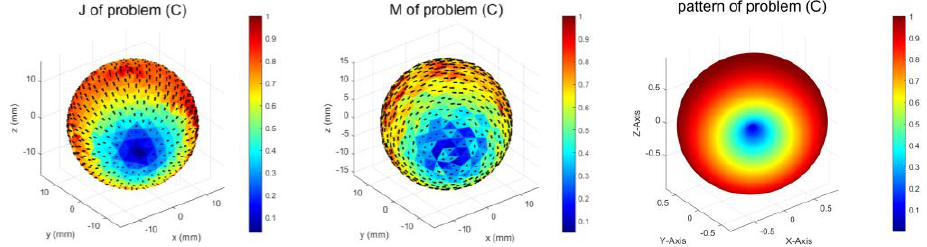
Figure 16. Characteristic current distributions and normalized pattern of mode 3 resonating near 4.3 GHz for problem (C) at 2.0 GHz, where the left column represents electric current, the middle column represents magnetic current, and the right column represents normalized pattern.